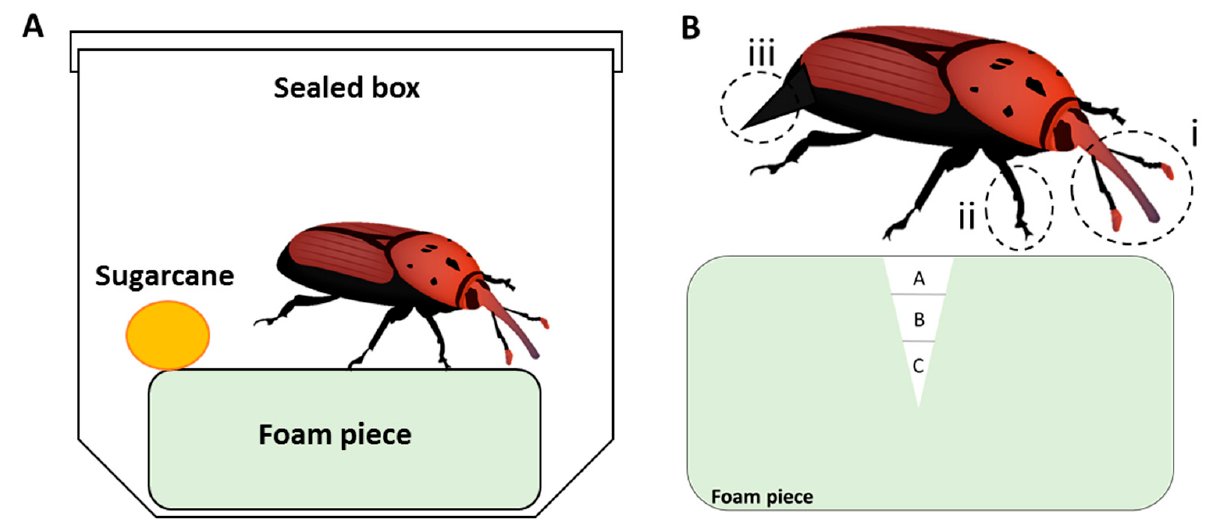
Figure 1. Schematic representation of the experimental microcosm used to evaluate the Mb7-GFP conidia acquisition and dissemination from foam piece to Rhynchophorus ferrugineus female and eggs, and the susceptibility of eggs and larvae to Mb7-GFP. ( A ) Each microcosm included a single mated female, a foam piece and a piece of sugarcane. ( B ) Schematic representation of a foam piece with a hole made by the female. Laying hole divided into three sections of 5 mm each: A, B, C, as depicted. (i) Mouth part (proboscis) and antennae, (ii) front leg, (iii)